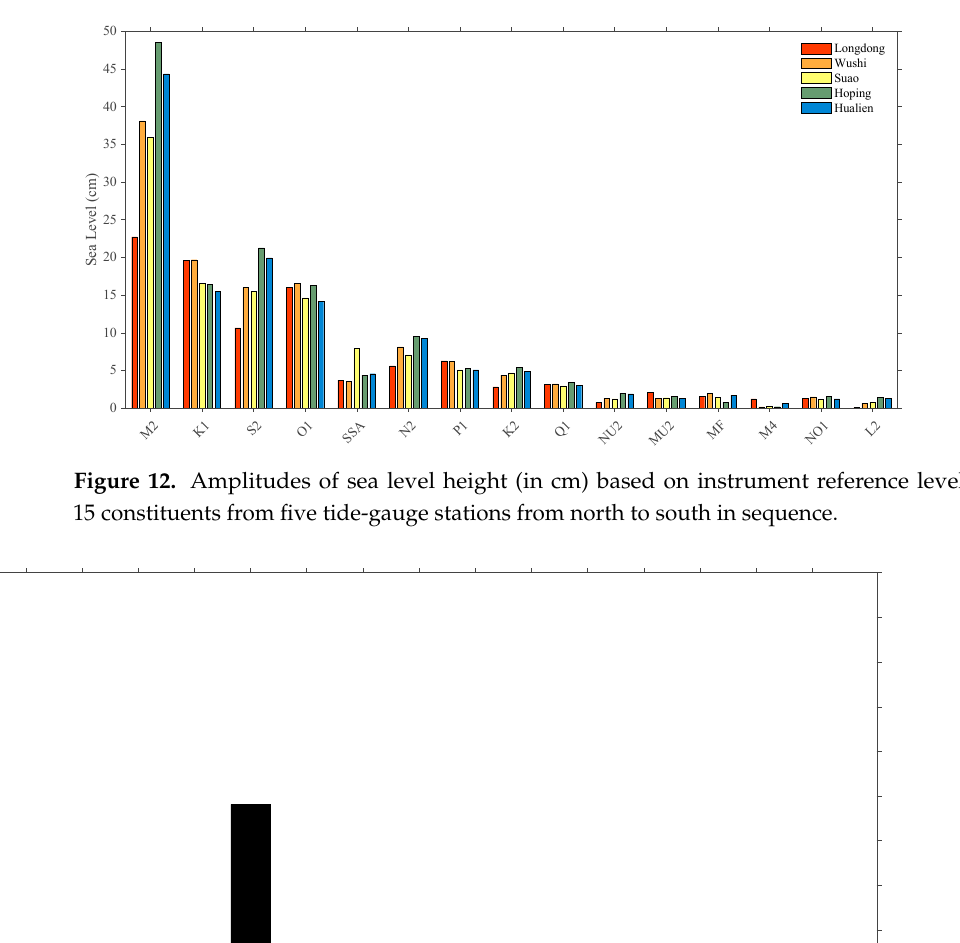
Table 4. Classification types of tidal